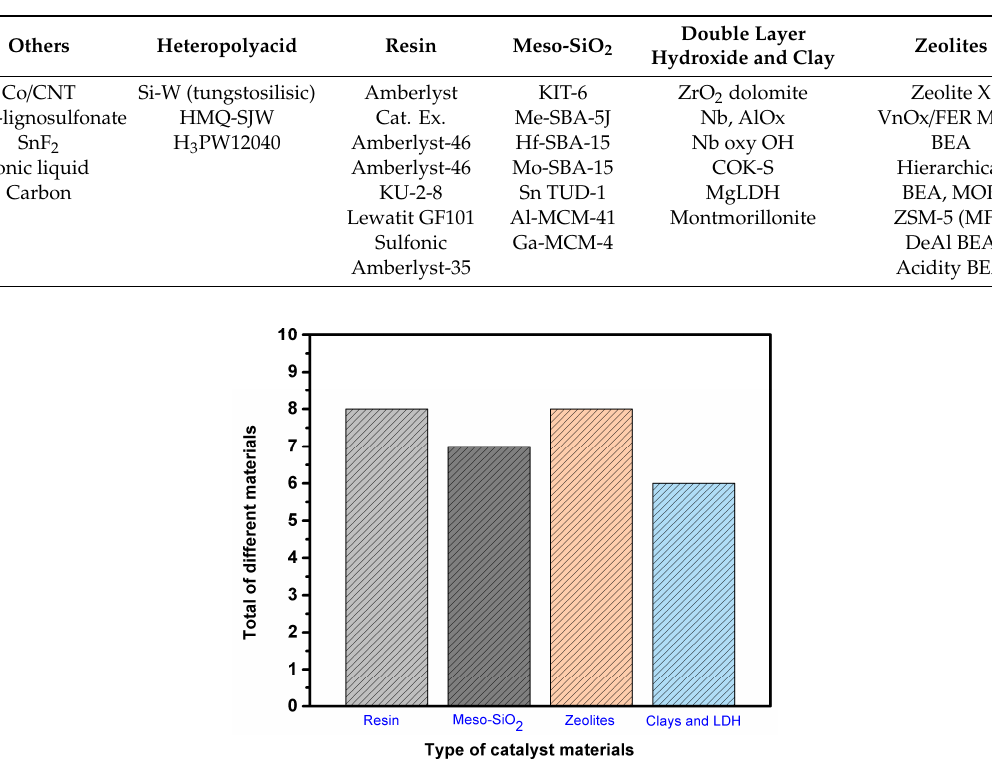
Table 2. Classification of heterogeneous catalysts for solketal production.